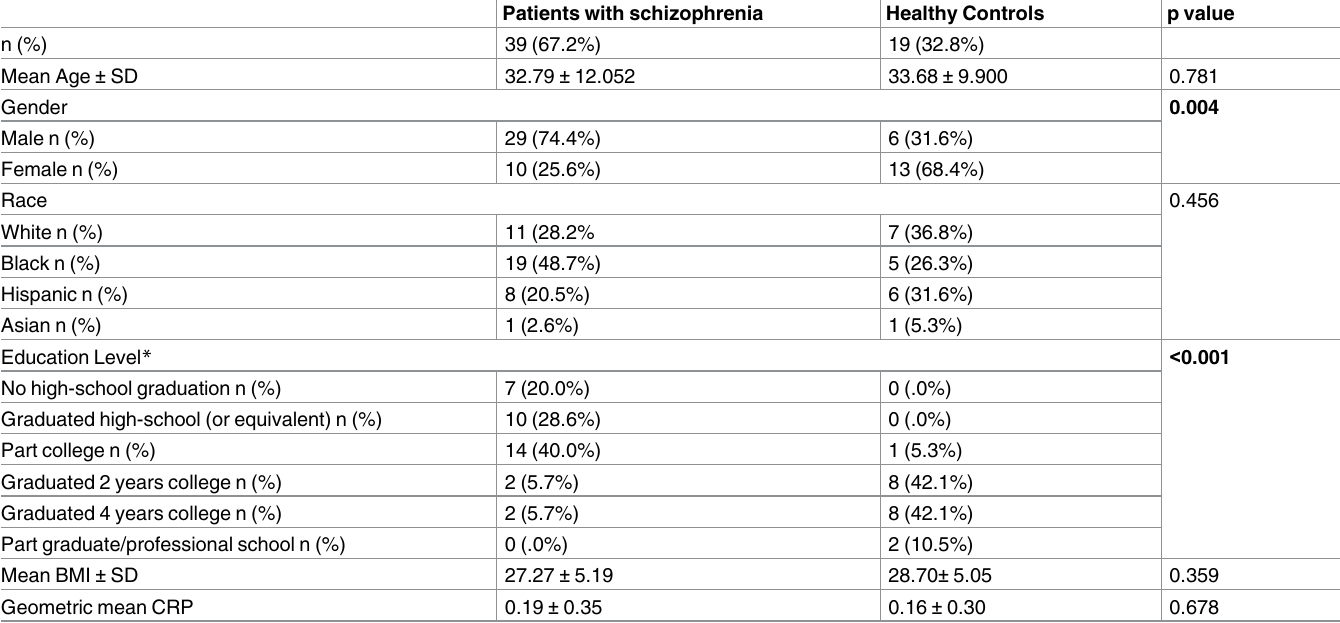
Table 1. Comparison of demographic characteristics of patients and control group. Patients with